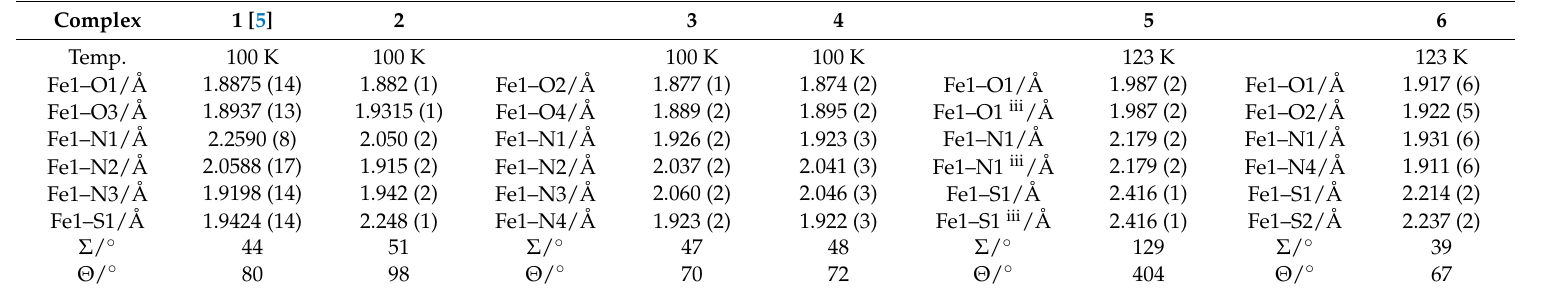
Table 2. Selected bond lengths and octahedral distortion parameters for 1 – 6